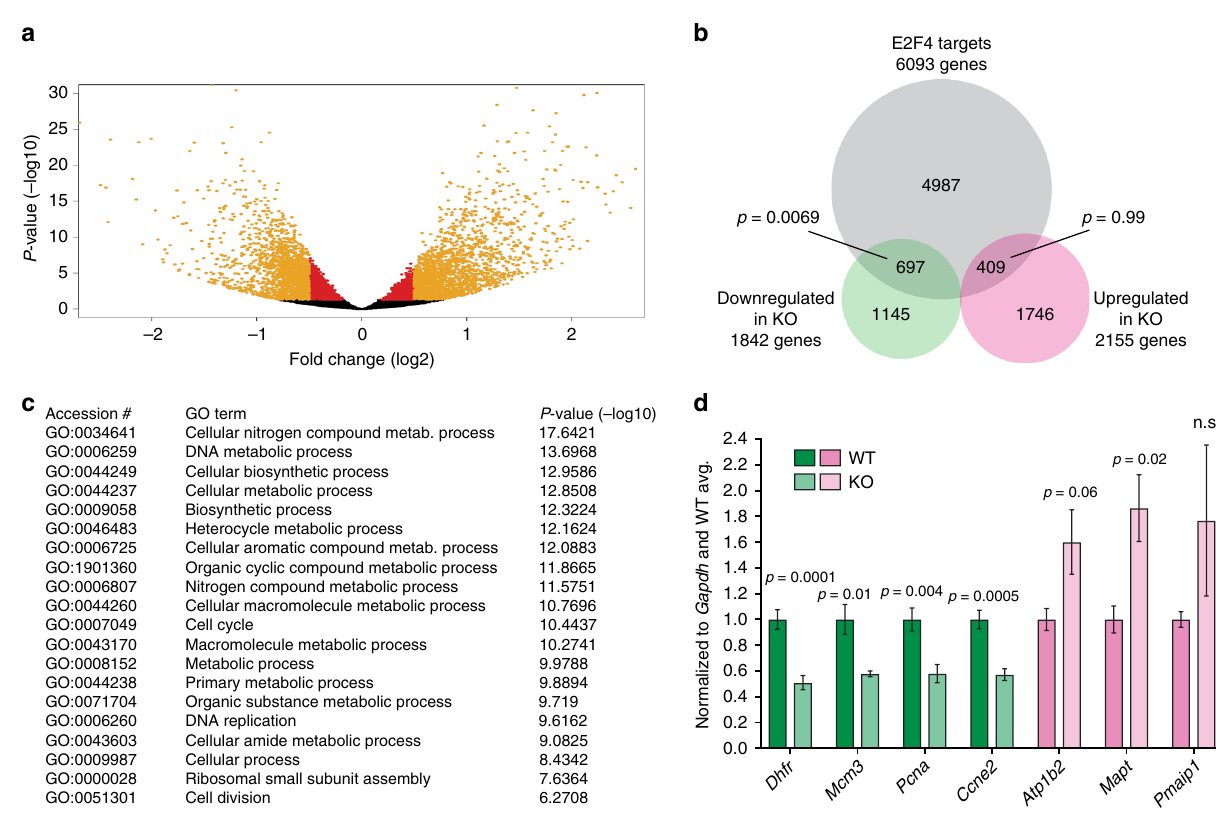
Fig. 3 Loss of E2F4 leads to genome-wide changes in gene expression. a Volcano plot of changes in gene expression upon E2F4 loss in mouse ES cells; y- axis represents -log10 transformation of p -value and x -axis represents log2 transformation of fold change. Red circles represent signi fi cantly changed genes ( q -value < 0.05) while orange circles represent signi fi cantly changed genes with a fold change > 0.5 (log2). b Overlap between E2F4 targets in mouse ES cells and genes differentially expressed in E2F4KO (KO)cells with respect to wild-type. c GO terms for biological processes enriched in genes downregulated in E2F4KO cells ( q -value < 0.05, fold change > 0.5 (log2)). GO terms were fi ltered for redundancy through REVIGO and the top 20 most signi fi cant are shown. d RT-qPCR validation of differentially expressed genes. Expression of downregulated genes in WT (dark green) and E2F4KO cells (light green); and upregulated genes in WT (pink) and E2F4KO cells (light pink), was normalized to Gapdh expression and then to expression levels in WT cells (unpaired t -test was performed with all individual data points from n = 2 – 4 biological replicates with 2 WT and 2 E2F4KO clones). Data shown as the mean and standard error of the